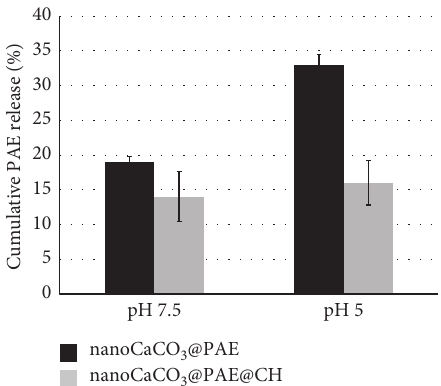
Figure 3: Cumulative PAE release from nanoformulations after 48h incubation at pH 7.5 and 5.